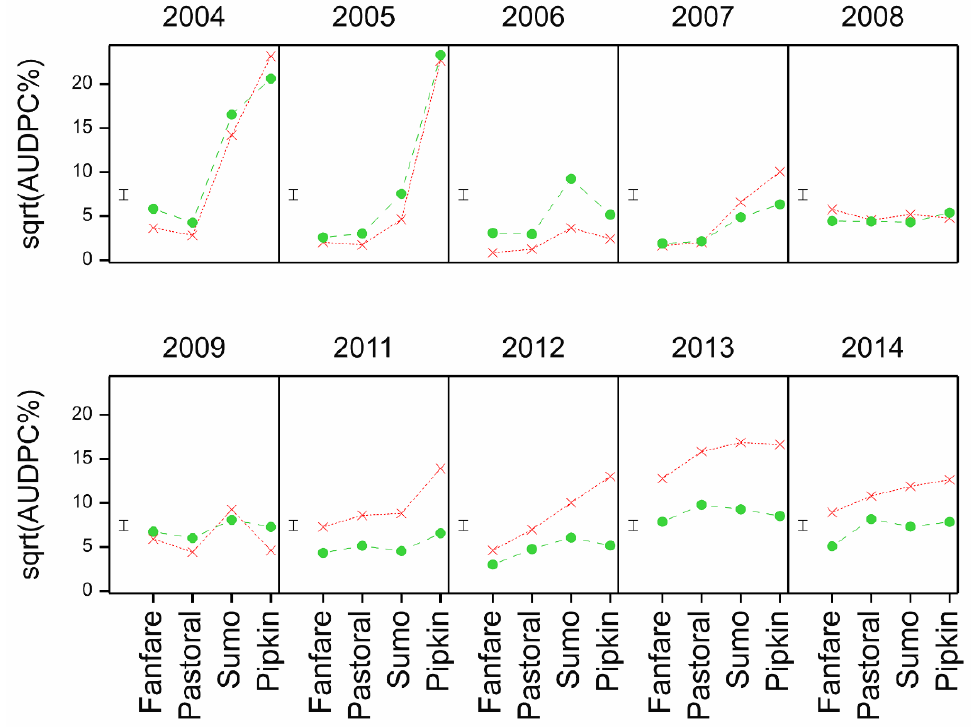
Figure 4. Comparison of rhynchosporium infection between maturing inversion (red) and non-inversion (green) tillage from 2004 to 2014. The bar shows the size of the SED for the interaction between cultivar and tillage type.